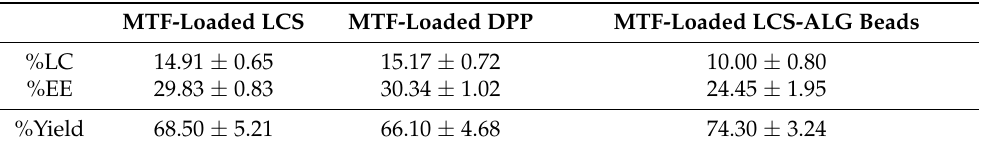
Table 1. Loading capacity (%LC), encapsulation efficiency (%EE), and production yield for MTF- loaded LCS, MTF-loaded DPP, and MTF-loaded LCS-ALG beads. Data are presented as (mean ± SE, n =